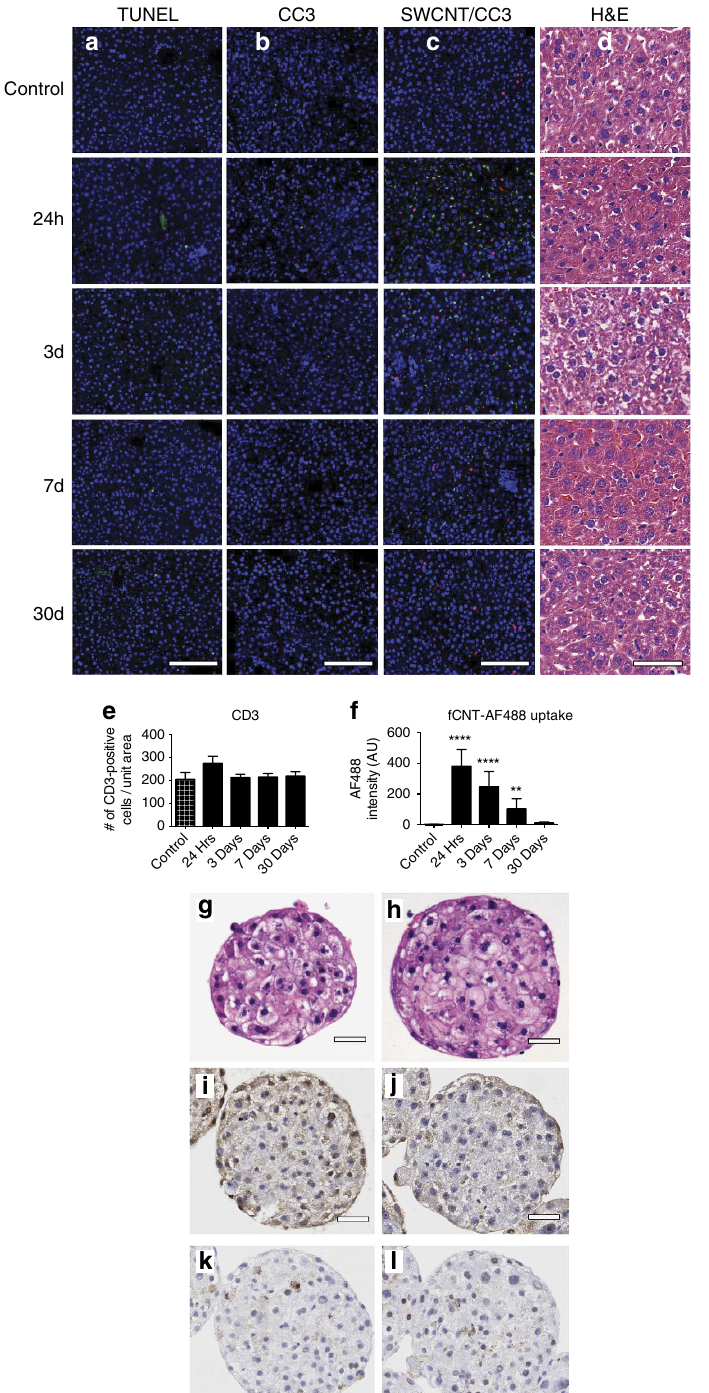
Figure 4 | Hepatic biocompatibility of fCNT. The biocompatibility of fCNT in immunocompetent mice was examined as a function of time (1, 3, 7 or